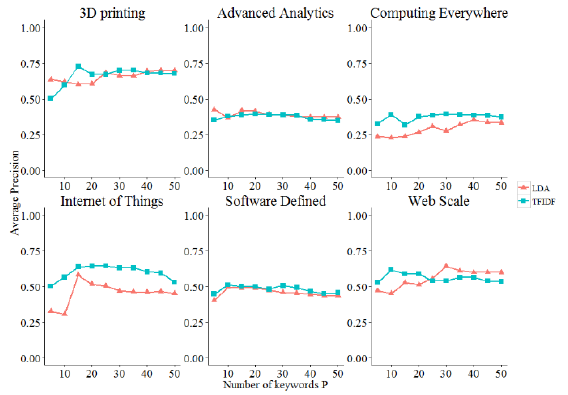
Fig. 8. Comparison of Keyword Extraction Model - Average Precision in each category across the number of keywords (red: LDA, blue: TFIDF)